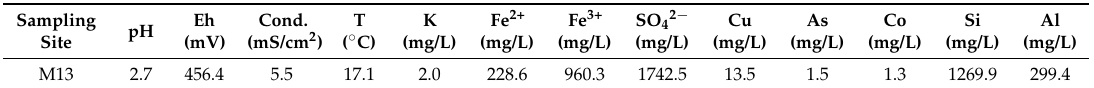
Table 1. Main physicochemical characteristics of sampling station M13. Orthophosphate concentration is below the detection limit (1 mg/L).